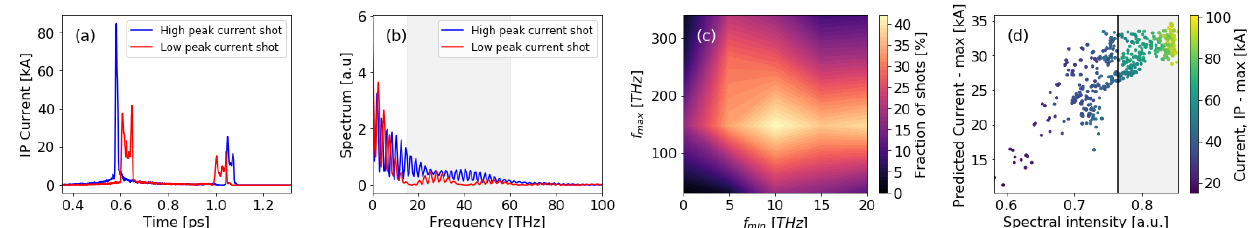
Figure 4. ( a ) Single shot current profile at the experimental IP of high and low peak current profile that would be appear similar on the TCAV and ( b ) their matching spectrum. ( c ) Fraction of shots that are within the TCAV resolution for various frequency bands. ( d ) Maximum predicted TCAV current vs integrated spectral intensity that was optimized to maximize the fraction of shots in ( c ). The corresponding maximum IP current is shown in the colorbar.